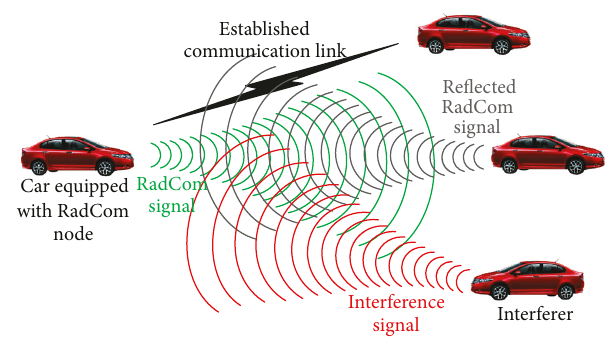
Figure 1: RadCom network in ITS applications